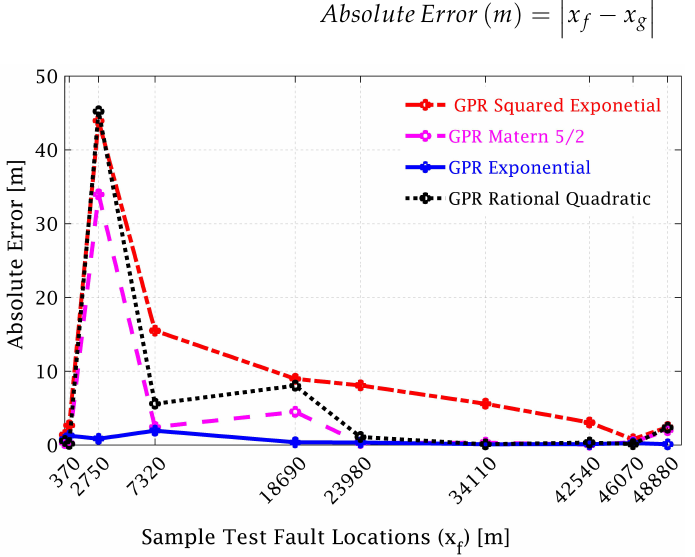
Figure 19. Comparison of the GPR models in the prediction of fault locations.